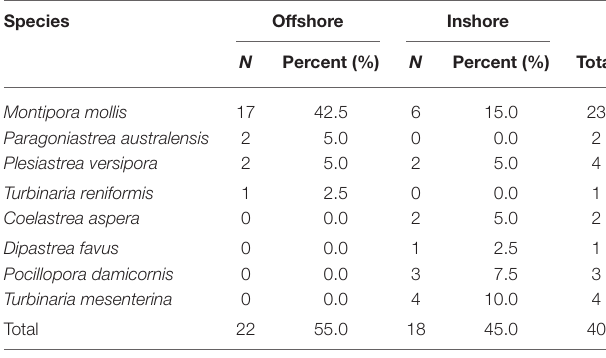
TABLE 2 | Species found with coral bleaching after the Marine Cold Spell on inshore and offshore reefs of Marmion Marine Park, Perth, Western Australia in timed